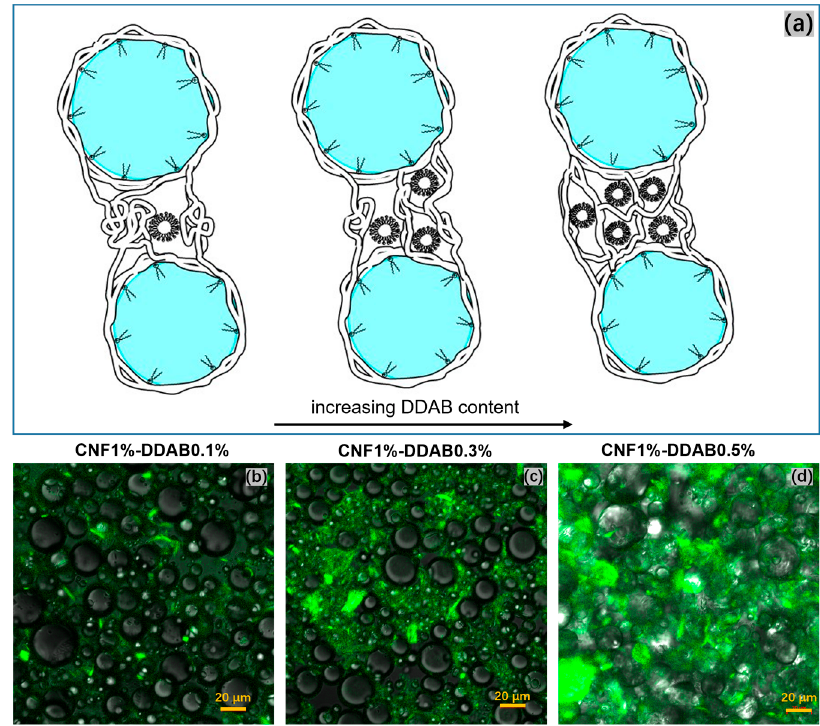
Figure 3. ( a ) Schematic representations of CNF distribution in aqueous phase with increasing DDAB micelle number (increasing DDAB concentration). Confocal laser scanning microscopy images of CNF emulsion with 1 wt.% CNF and ( b ) 0.1, ( c ) 0.3, and ( d ) 0.5 (wt.%) DDAB after being stained with Calcofluor white, which shows the green areas of spreading CNF chains over aqueous phase.